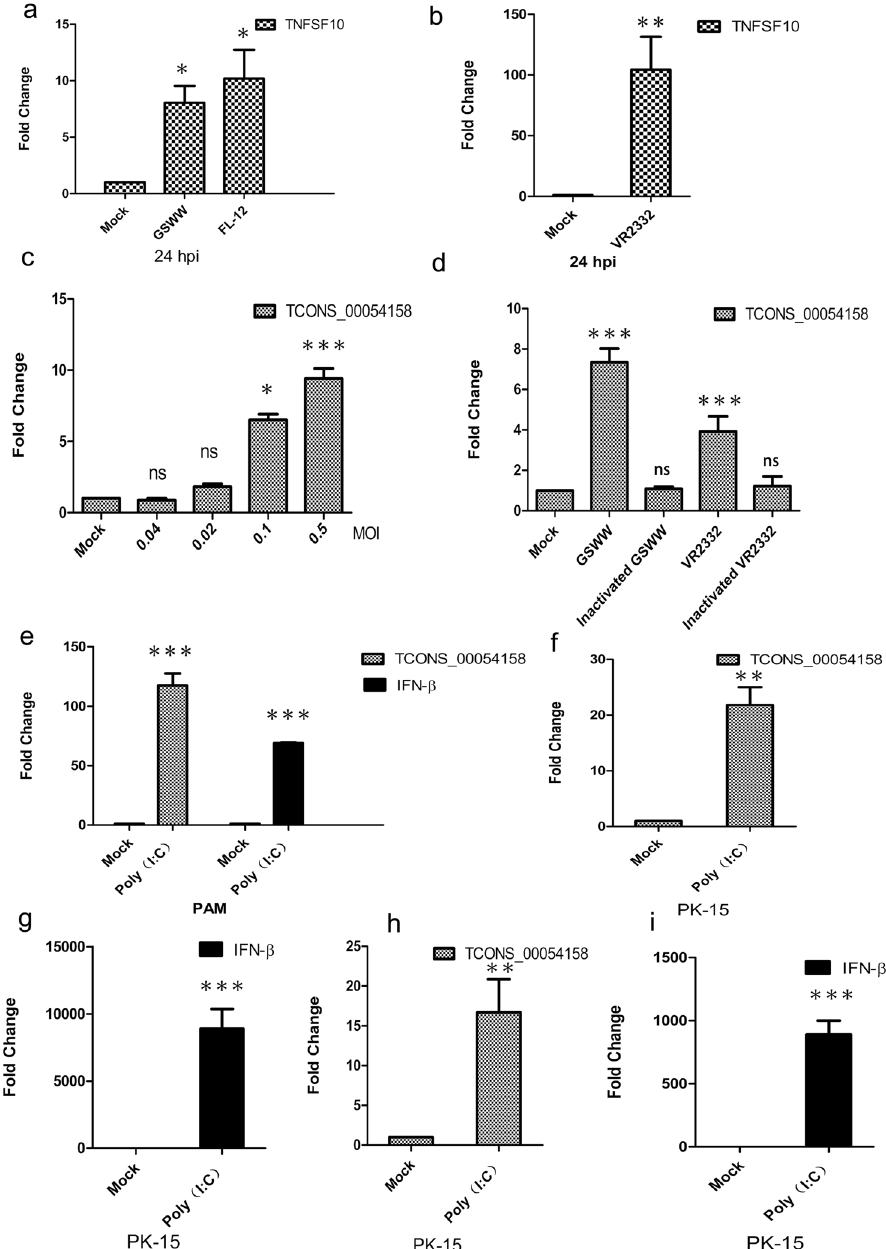
Figure 6. The expression levels of TNFSF10, TCONS_00158758 and IFN- β . Expression levels were normalized to GAPDH. Data are the means ± S.D. of three independent experiments. *** p < 0.001, ** p < 0.01, * p < 0.05, one-way analysis of variance followed by Dunnett’s multiple comparison test or Student’s t-test was performed. ( a ) and ( b ). PAM cells were mock infected or infected with GSWW, FL-12 and VR2332 (at the MOI of 1). Total RNA was extracted 24 hpi and the first-strand cDNA was synthesized. RT-qPCR experiments were performed to detect TNFSF10 expression. ( c ) RT-qPCR results showing fold change in lncRNA TCONS_00158758 expression level in PAM cells at 24 hpi with gradient GSWW infection. A total of 10 7 cells were plated in 25 cm 2 flasks and mock infected or infected with 0.5 MOI, 0.1 MOI, 0.02 MOI, 0.004 MOI of GSWW per flask. ( d ) RT-qPCR data of lncRNA expression in PAM cells that were mock infected or infected with live GSWW, and VR2332 (at the MOI of 0.1) or heat-inactivated (56 °C, 120 min) viruses at 24 hpi. ( e ) PAM cells were treated with 100 µ g/ml poly (I:C) for 24 hours. Total RNA was extracted and the first-strand cDNA was synthesized. RT-qPCR experiments were performed to detect the expression of IFN- β and lncRNA TCONS_00054158. ( f ) and ( g ) PK-15 cells were transfected with 2 µ g/ml poly (I:C) for 24 hours. Total RNA was extracted and the first strand cDNA was synthesized. RT-qPCR experiments were performed to detect the expression of IFN- β and lncRNA TCONS_00054158. ( h ) and ( i ). PK-15 cells were treated with 100 µ g/ml poly (I:C) for 24 hours. Total RNA was extracted and the first strand cDNA was synthesized. RT-qPCR experiments were performed to detect the expression of IFN- β and lncRNA